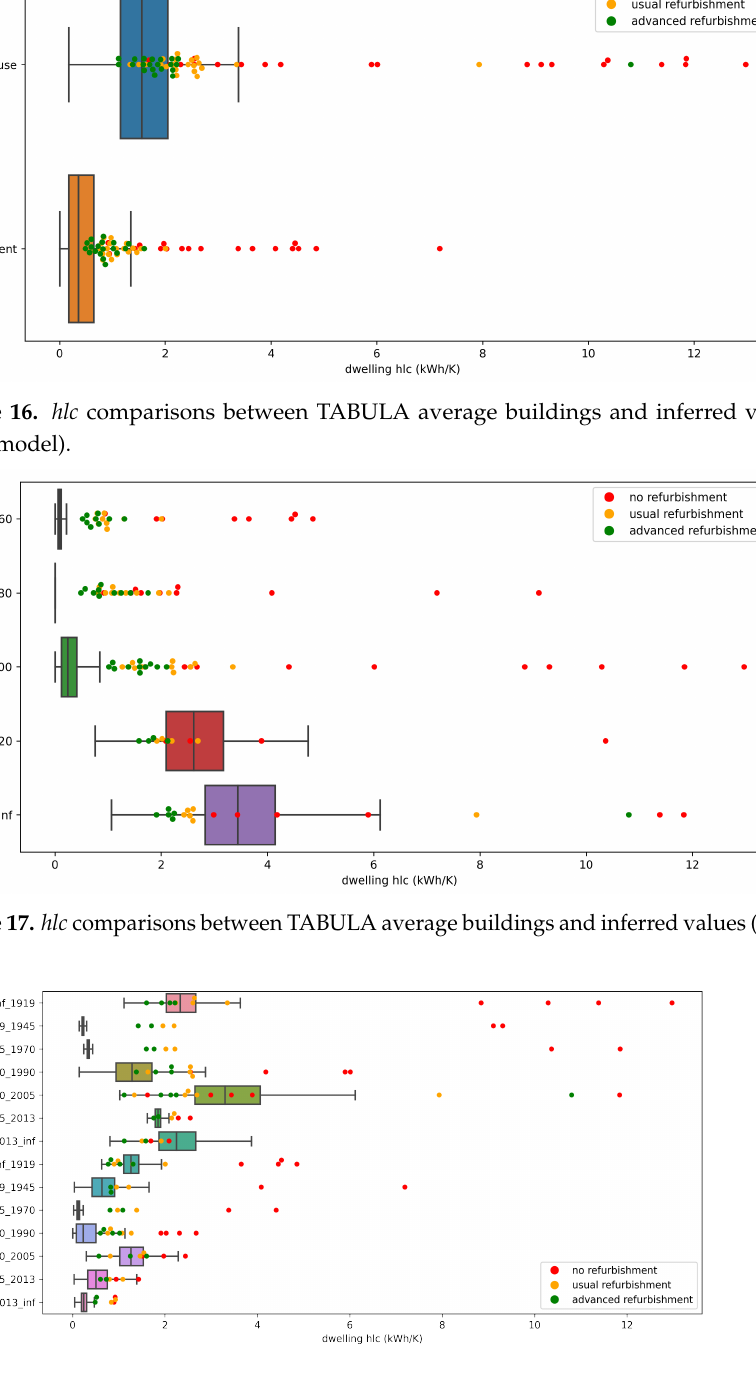
Figure 18. hlc comparisons between TABULA average buildings and inferred values (types and dates